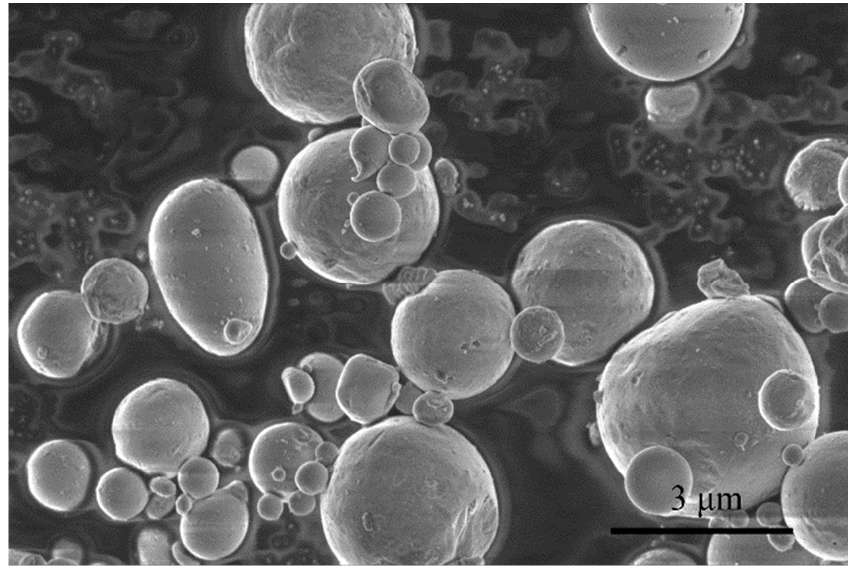
Figure 1. Morphology of aluminum powders.